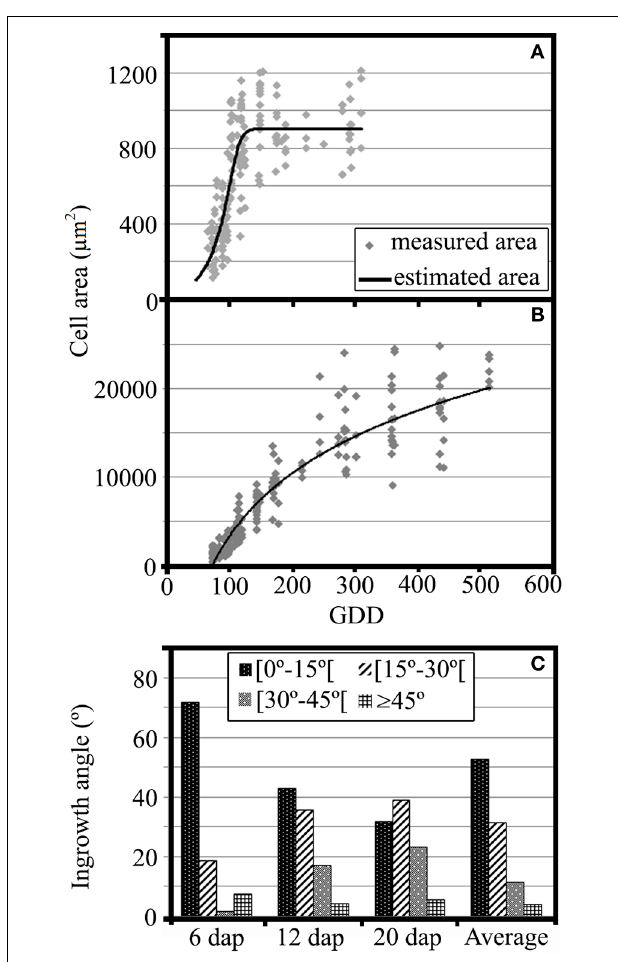
FIGURE 3 | (A) Growth analysis of MBETCs, showing cell areas ( µ m 2 ) of developing kernels (4–20 DAP, equivalent to 62.0–300.2 GDD) and adjusted growth curve (cell area = 903 . 04 /( 1 + exp ( 15 . 81 − 0 . 15 × GDD ) ∧ ( 1 / 4 . 37 )) , R 2 = 67 . 15%). (B) Growth analysis of starchy cells, showing cell areas ( µ m 2 ) of developing kernels (5–35 DAP, equivalent to 73.5–522.0 GDD) and adjusted growth curve (cell area = − 43582 . 6 + 10195 . 3 × ln ( GDD ) , R 2 = 92 . 3%). (C) Flange ingrowth angles (in relation to the nearest anticlinal wall) of developing MBETCs (6, 12, and 20 DAP, and an average of the three sampling